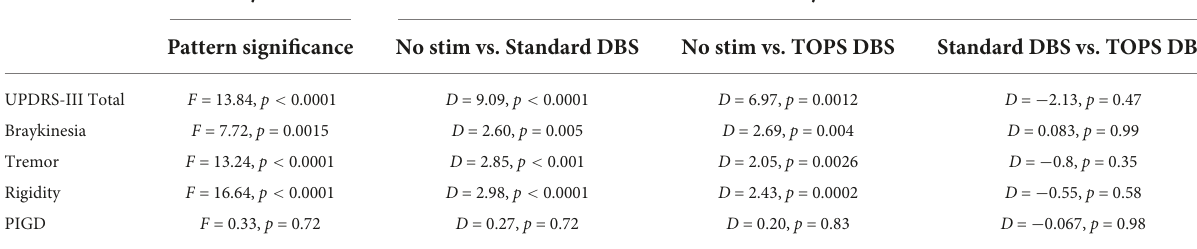
TABLE 3 Significance of stimulation patterns on UPDRS-III and motor subscores ( D = mean difference). One-way